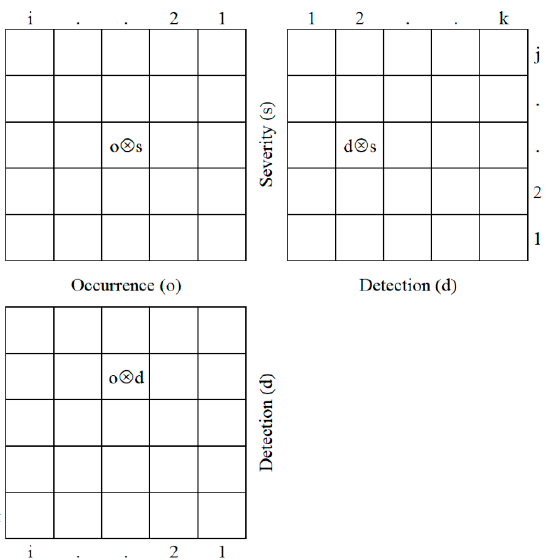
Figure A1. Visualization of pattern in partial risk map (PRISM) (Bognár and Heged ű s 2022). Table A1. Traditional judgment scores in AHP (Menon and Ravi 2022).